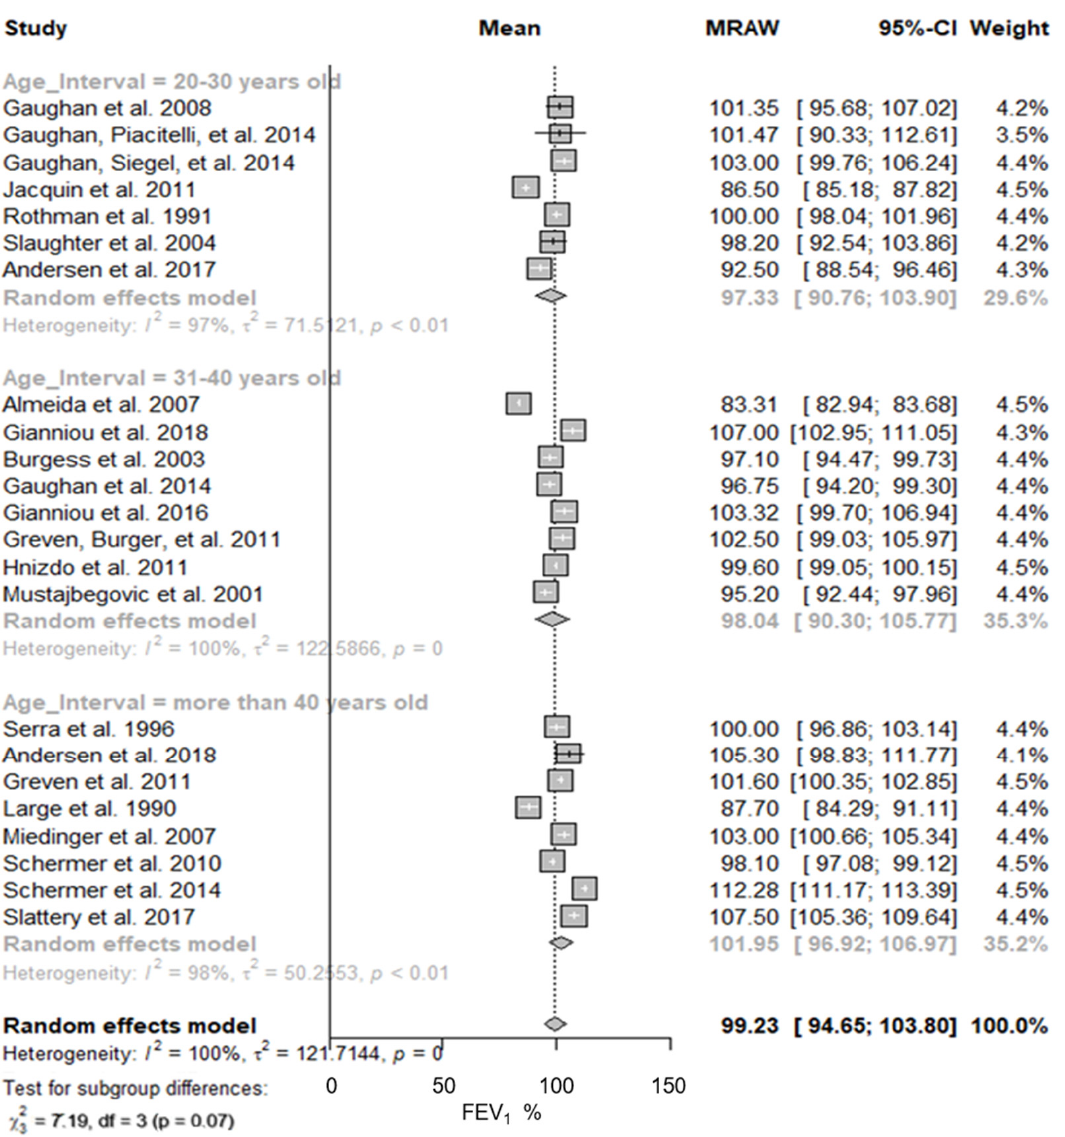
Figure 4. Predicted FEV 1 in firefighters stratified by participants’ age. Forest plot displaying the weight of the predicted FEV 1 mean value and heterogeneity [13,40–54,56–62]. Smoking practices showed that the lung function in non-smoker firefighters was higher than in smokers, being 101.28% (95% CI: 97.59–104.96%; I 2 = 98%) and 97.03% (95% CI: 91.09–102.98%; I 2 = 99%), respectively (Figure 5). Identical results were obtained for the predicted FVC mean values (Table